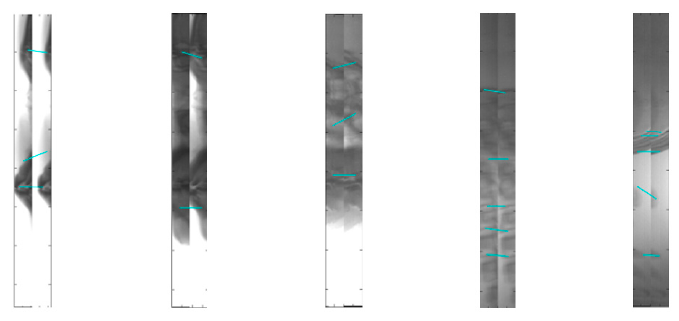
Figure 2. SIFT feature extraction and matching results.